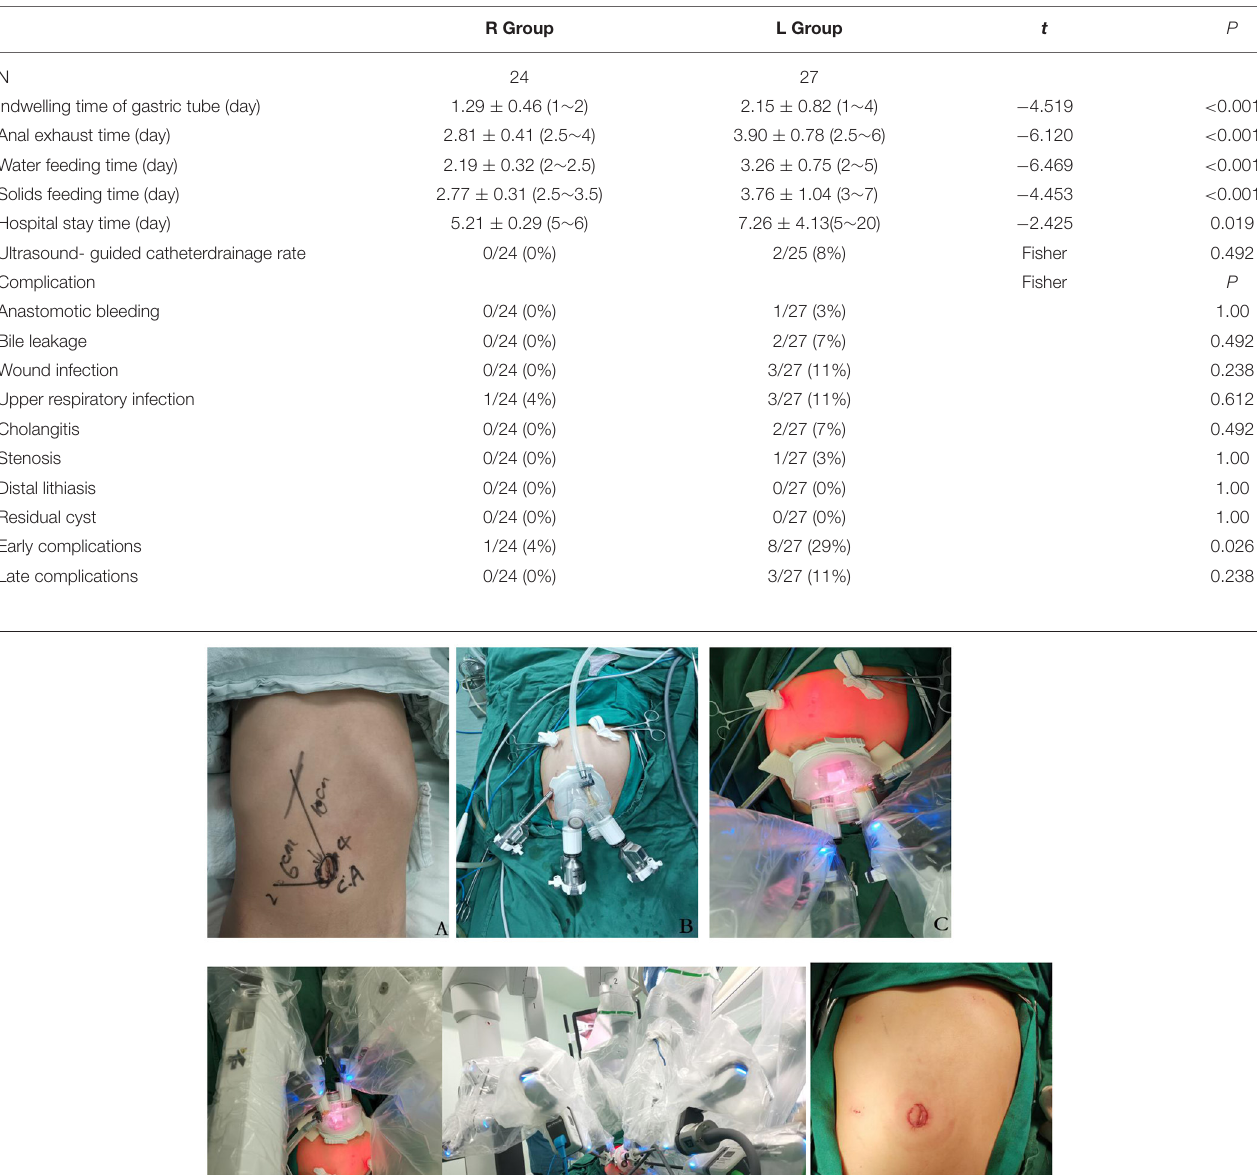
TABLE 3 | Postoperative outcomes.